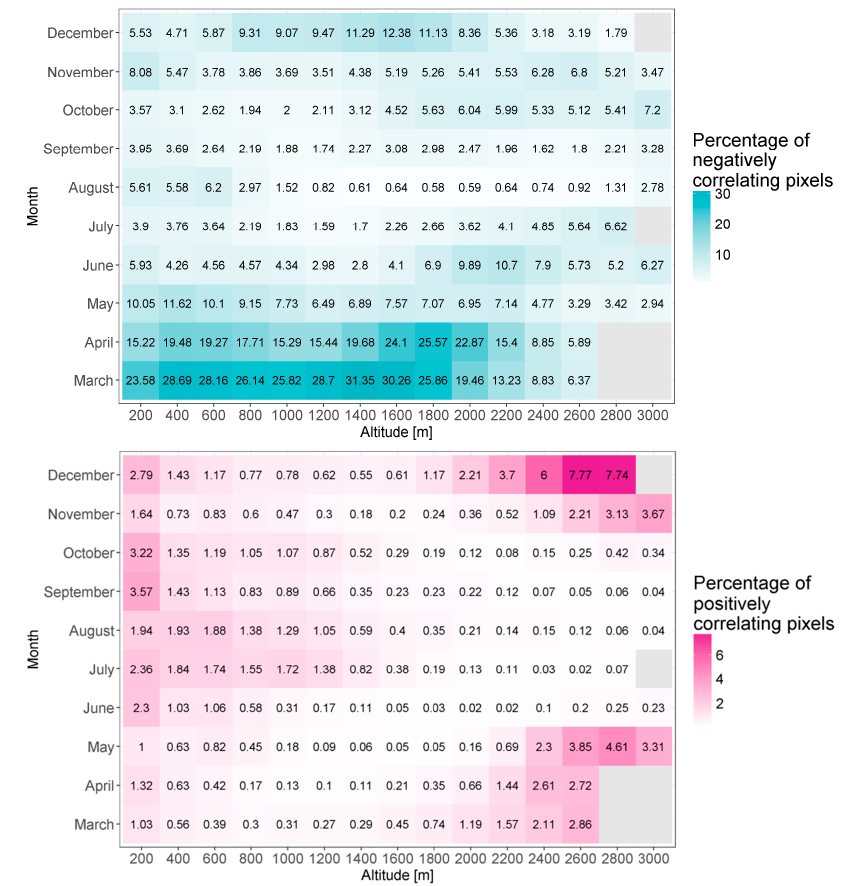
Figure 13. Percentages of negatively and positively correlating pixels of the December (violet), January (orange) and February (red), longer winter (green) and shorter winter (blue) SCD with the following monthly mean NDVIs.